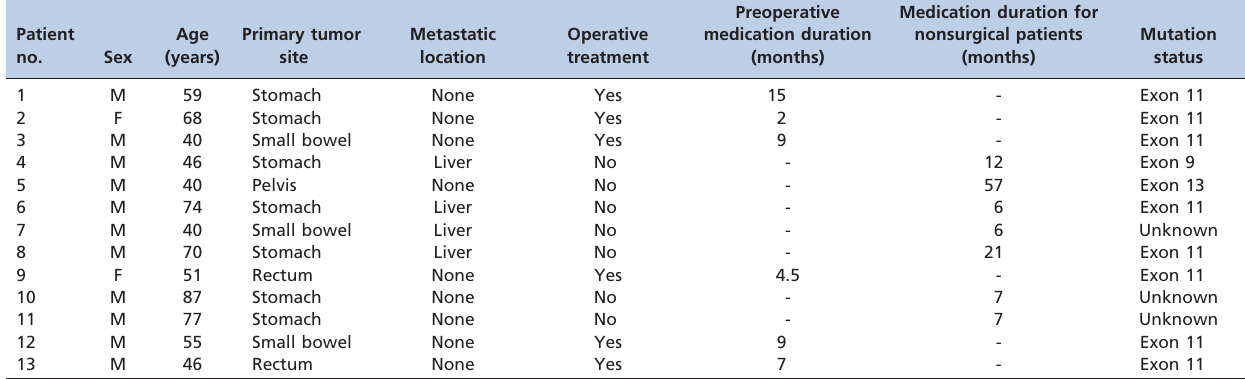
Table 1 - Main clinical characteristic of patients with primary GIST. Patient